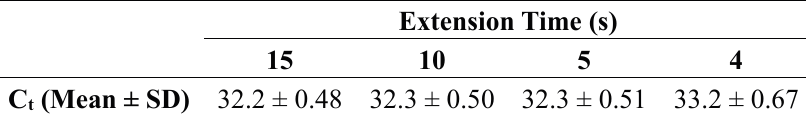
Table 3. C t values extension time of 15, 10, 5, and 4 s, respectively, with denaturation and annealing time of 30 s,